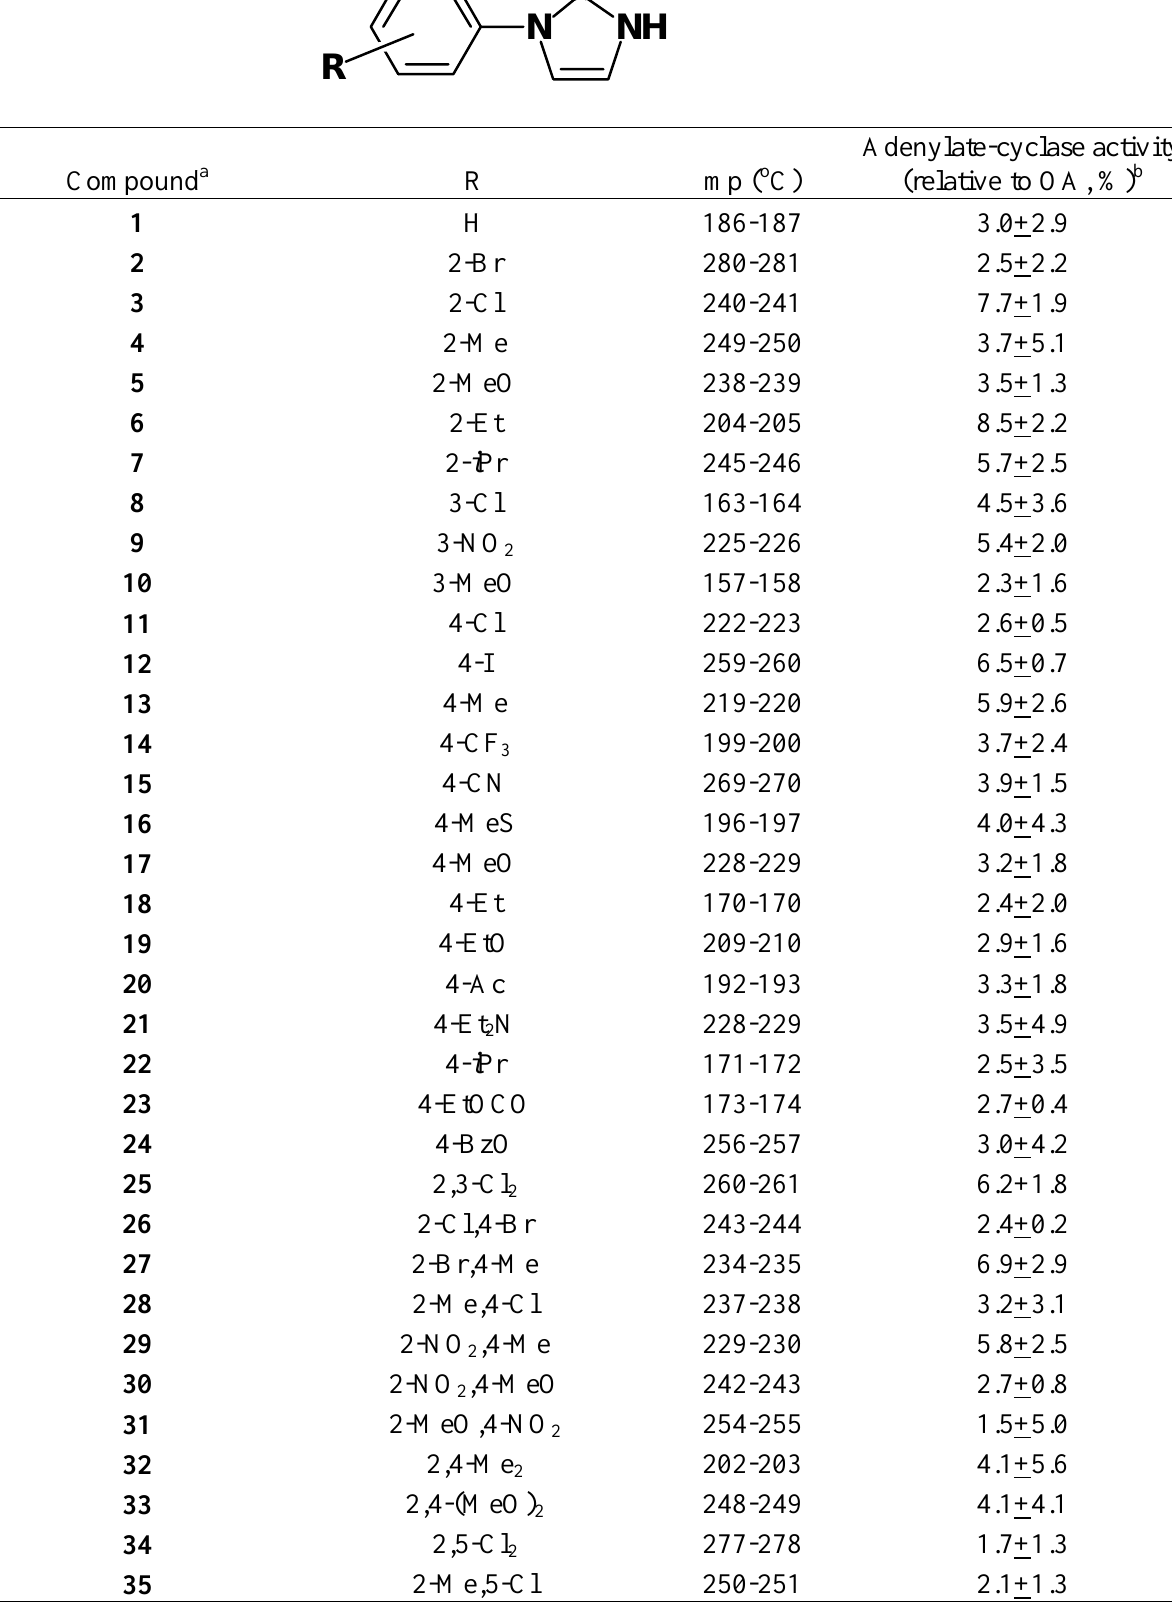
Table 1. OA agonist AIHTs used in this